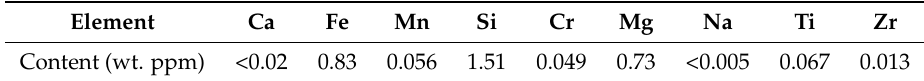
Table 2. Chemical properties of AA6082; provided by the manufacturer (ALRO S. A, Slatina, Romania). Element Si Content (wt.%) Table 3. Chemical properties of Al5N; provided by the manufacturer (HMW Hauner GmbH & Co. KG, Röttenbach, Germany, obtained by Optical Emission Spectroscopy).